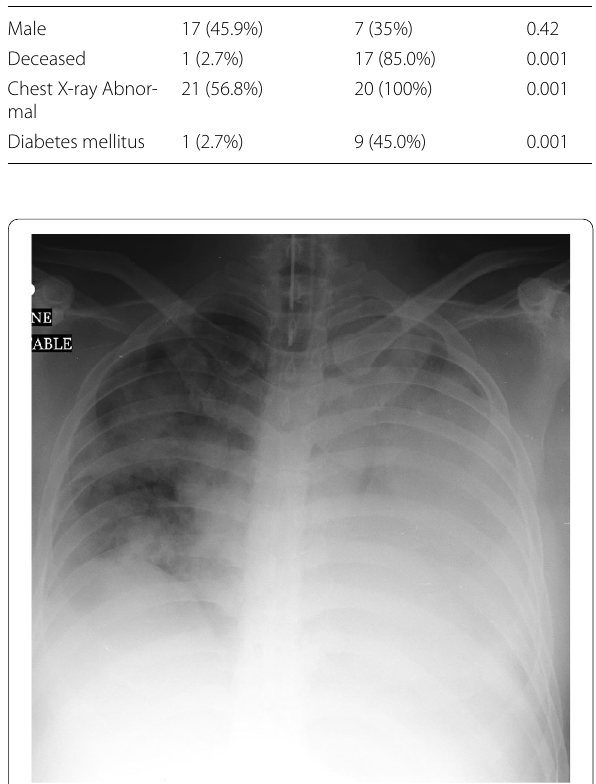
Fig. 3 A 52-year-old man who developed Middle East respiratory syndrome coronavirus. Frontal chest radiograph obtained on day 8 shows bilateral multifocal patchy airspace disease with predominant hemiopacification of the left lung; chest radiographic score is 14 with LDH of 760. The patient died ten days after initial admission